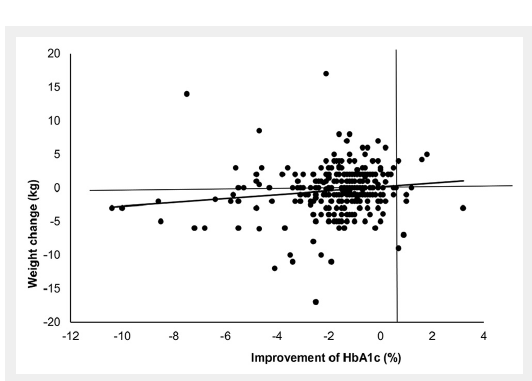
Assessment of efficacy (blood glucose control) by physician, evaluation of satisfaction with therapy and device by patients: Proportions of physicians and patients who were “very satisfied”, “satisfied”, “dissatisfied” or “very dissatisfied” (per protocol population, n = 300).